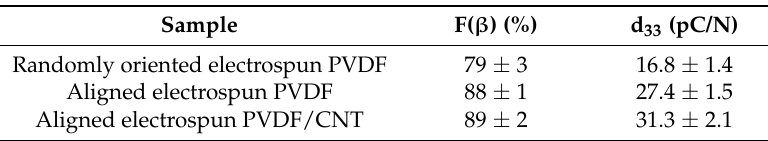
Table 1. F( β ) values and piezoelectric coefficients of the PVDF